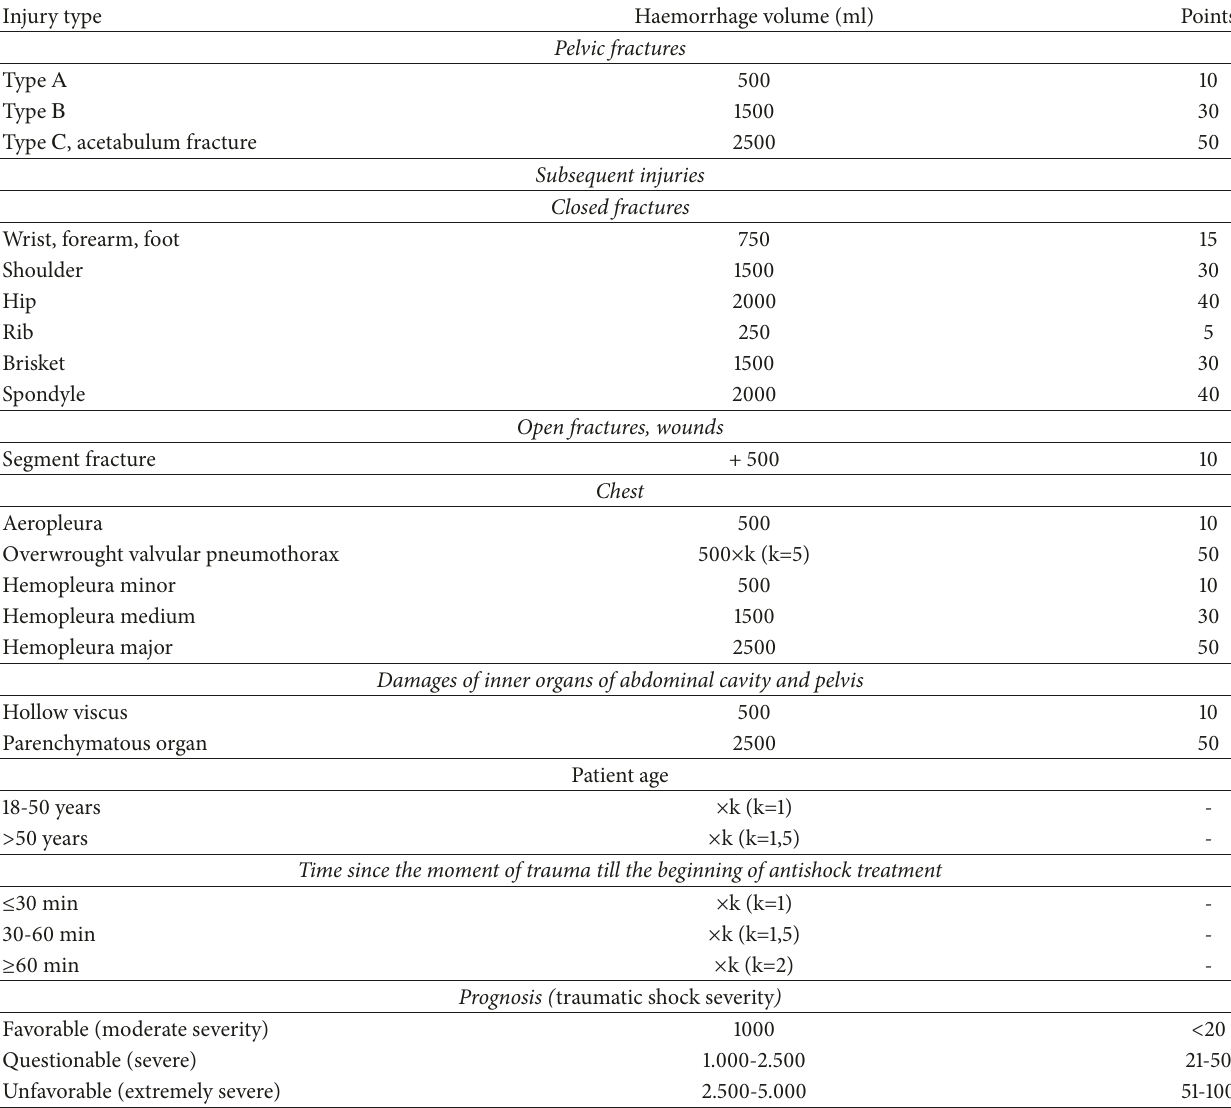
Table 2: Prognosis of traumatic shock severity in pelvic